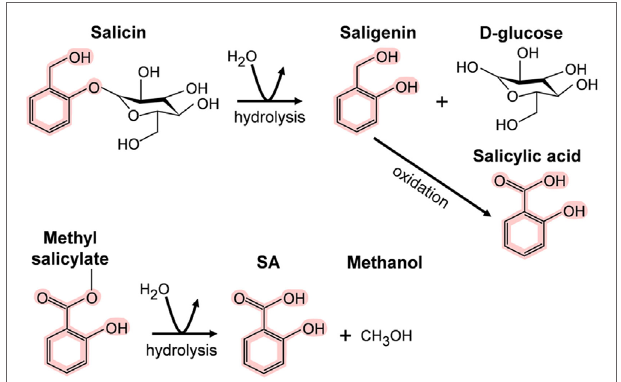
FiGURe 1 | Metabolism of salicin and methyl salicylate to salicylic acid (SA) . The SA core is highlighted in